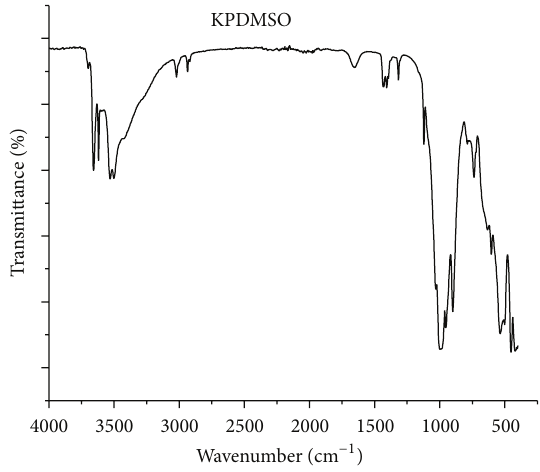
Figure 7: ATR-FTIR spectrum of